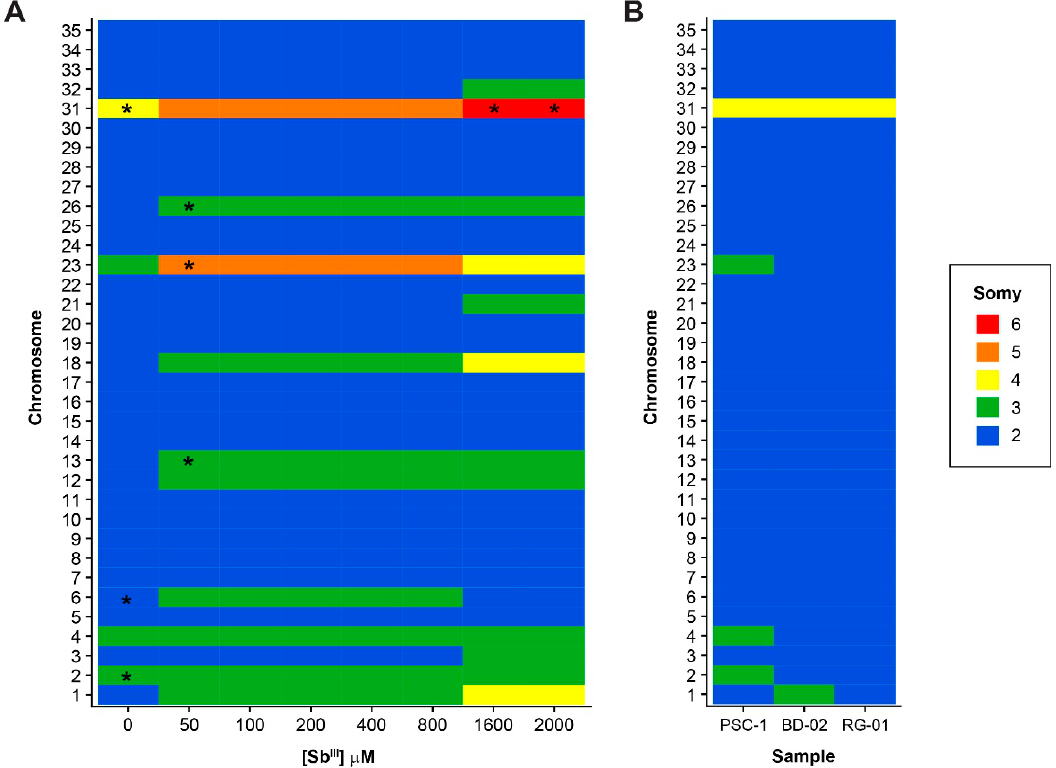
Figure 2. Variations in chromosome somy among all the samples included in this study. Estimates of the somy of each individual chromosome are shown for Sb-treated samples ( A ) and clinical isolates ( B ). The untreated PSC-1 strain is included as a control in both panels. Asterisks ( * ) indicate samples with values suggesting “intermediate” somy, defined as those estimated to be 0.5 units higher than the lower nearest integer by at least one of the methodologies used. In the heatmaps, values were approximated to the nearest integer to simplify the figure, using the following ranges: 2 : ≥ 1.5, < 2.5; 3 : ≥ 2.5, < 3.5; 4 : ≥ 3.5, < 4.5; 5 : ≥ 4.5, < 5.5 and 6 : ≥ 5.5, <